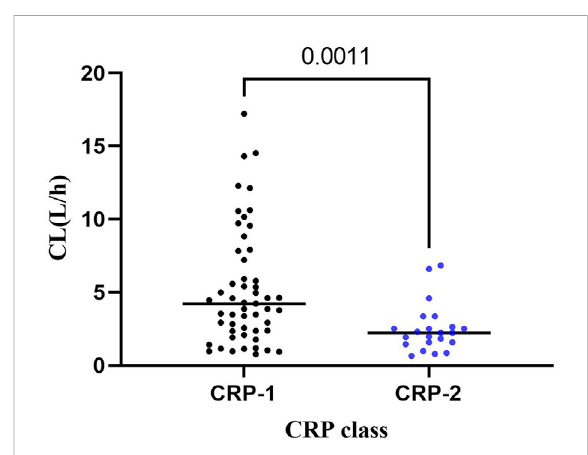
FIGURE 3 Distribution of VRC CL in CRP-1 and CRP-2 groups. CRP-1: CRP ≤ 96 mg/L; CRP-2: CRP > 96